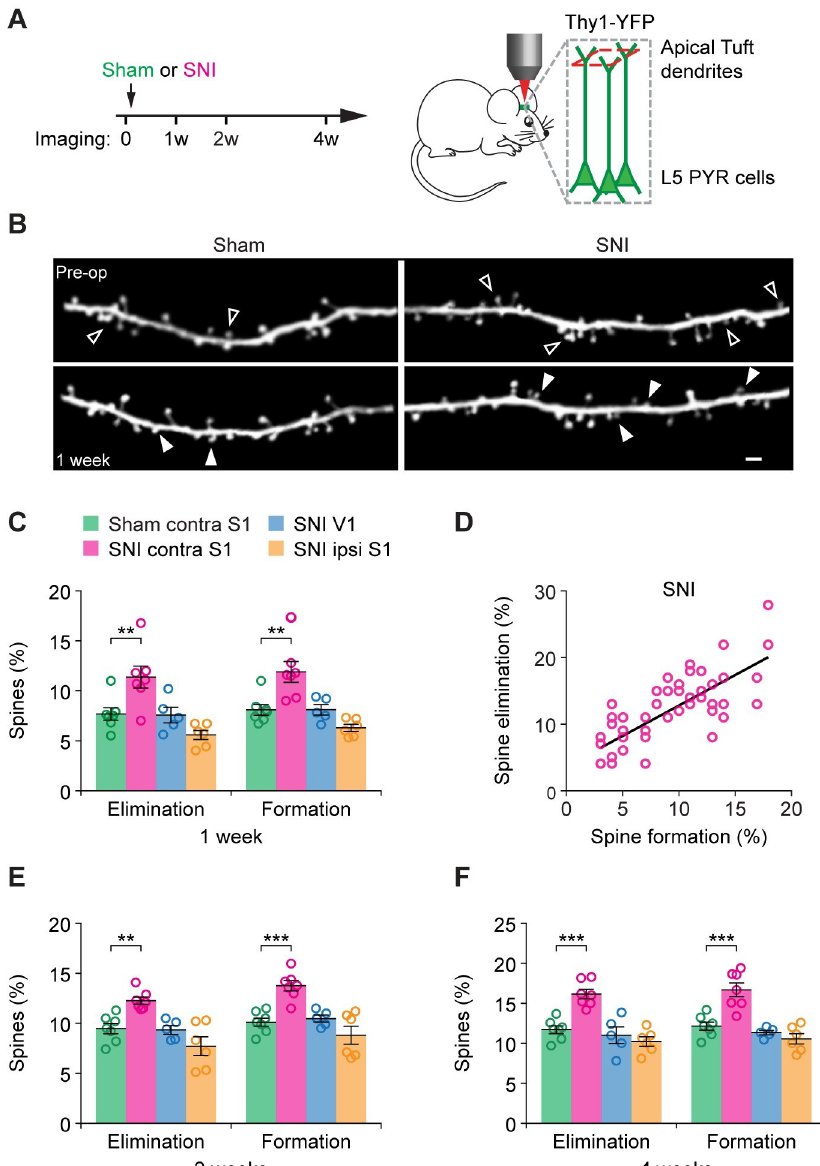
Fig 3. Persistent dendritic spine remodeling in the S1 after peripheral nerve injury. ( A ) Schematic showing the timeline for transcranial two-photon imaging and SNI or sham operation. Imaging was performed in transgenic mice expressing YFP in L5 PYR neurons. ( B ) Representative two-photon images of dendritic spines on apical dendritic segments of L5 pyramidal neurons in the S1 of SNI and sham mice. Empty and filled arrow heads indicate spines that were eliminated or newly formed, respectively, on the same dendritic segment. Scale bar, 2 μ m. ( C ) Percentages of dendritic spines eliminated and formed in various cortical areas 1 week after SNI or sham surgery (Elimination: F 3, 21 = 9.455, P = 0.0004; Formation: F 3, 21 = 11.54, P = 0.0001). Sham contra S1, 1,074 spines, n = 7 mice; SNI contra S1, 1,106 spines, n = 7 mice; SNI V1, 716 spines, n = 5 mice, SNI ipsi S1, 874 spines, n = 6 mice. ( D ) Correlation between the rates of spine elimination and spine formation 1 week after SNI (Pearson r = 0.77, P < 0.0001). ( E ) Percentages of dendritic spine elimination and formation 2 weeks after surgery (Elimination: F 3, 21 = 10.7, P = 0.0002; Formation: F 3, 21 = 13.84, P < 0.0001). ( F ) Percentages of dendritic spine elimination and formation 4 weeks after surgery (Elimination: F 3, 21 = 17.25, P < 0.0001; Formation: F 3, 21 = 18.49, P < 0.0001). Individual circles represent data from a single mouse. Summary data are presented as mean ± SEM. �� P < 0.01, ��� P < 0.001; by one-way ANOVA followed by Tukey multiple comparisons test ( C , E , F ). ( B ) Representative images from experiments carried out on at least 5 animals per group. The data underlying this figure can be found in S1 Data. L5, layer 5; PYR, pyramidal; SNI, spared sciatic nerve injury; S1, primary somatosensory cortex; YFP, yellow fluorescent protein.